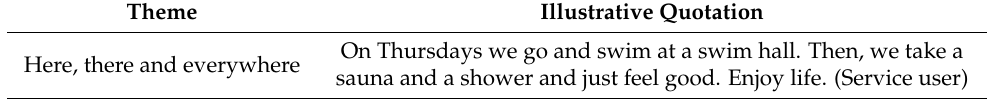
Table 1. Themes and illustrative quotes for “Spontaneous planned complexity”. Theme Illustrative